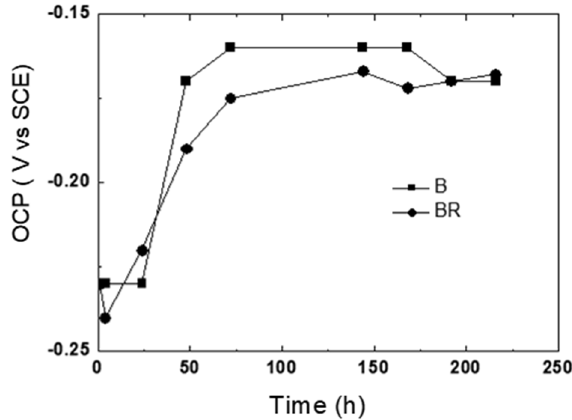
Figure 13. Variation of the OCP values with the immersion time in a chlorinated solution. 380